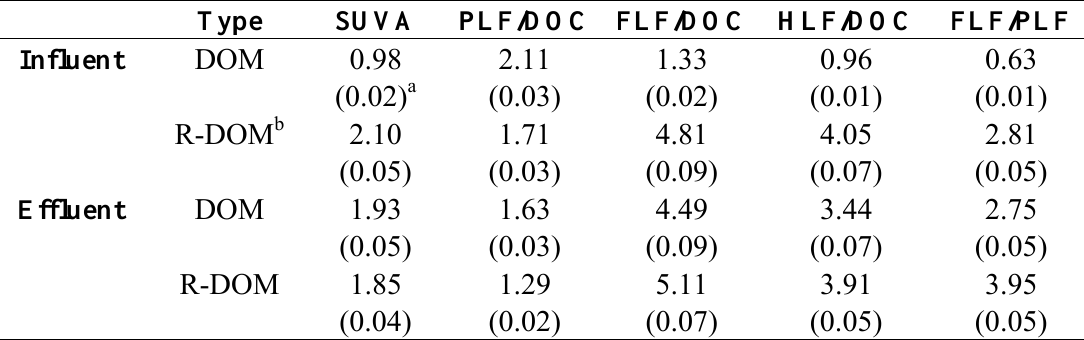
Table 2. Spectroscopic characteristics of influent and treated sewage from a wastewater treatment